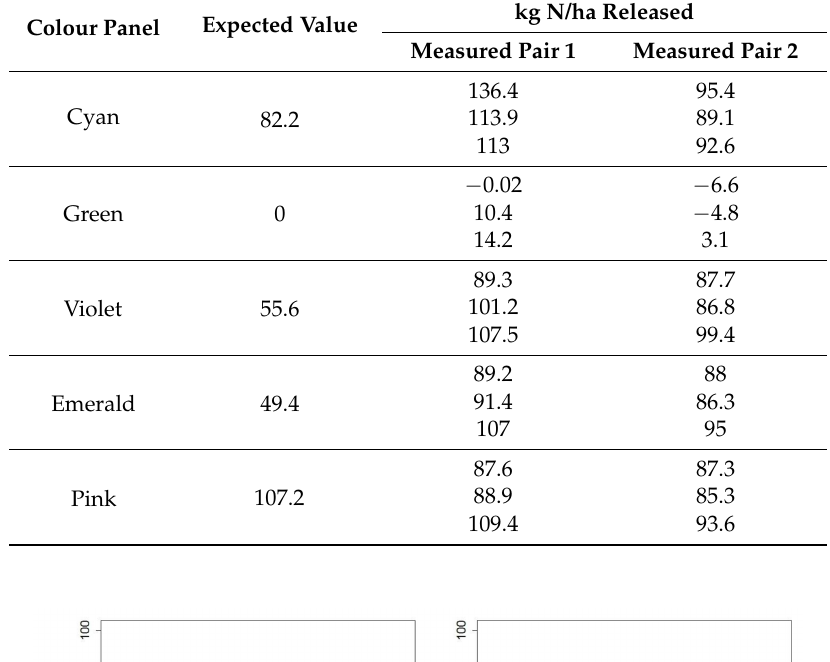
Table 4. Comparison of the expected amount of fertilizer to be released per fluted roller pair to the actual released amounts.